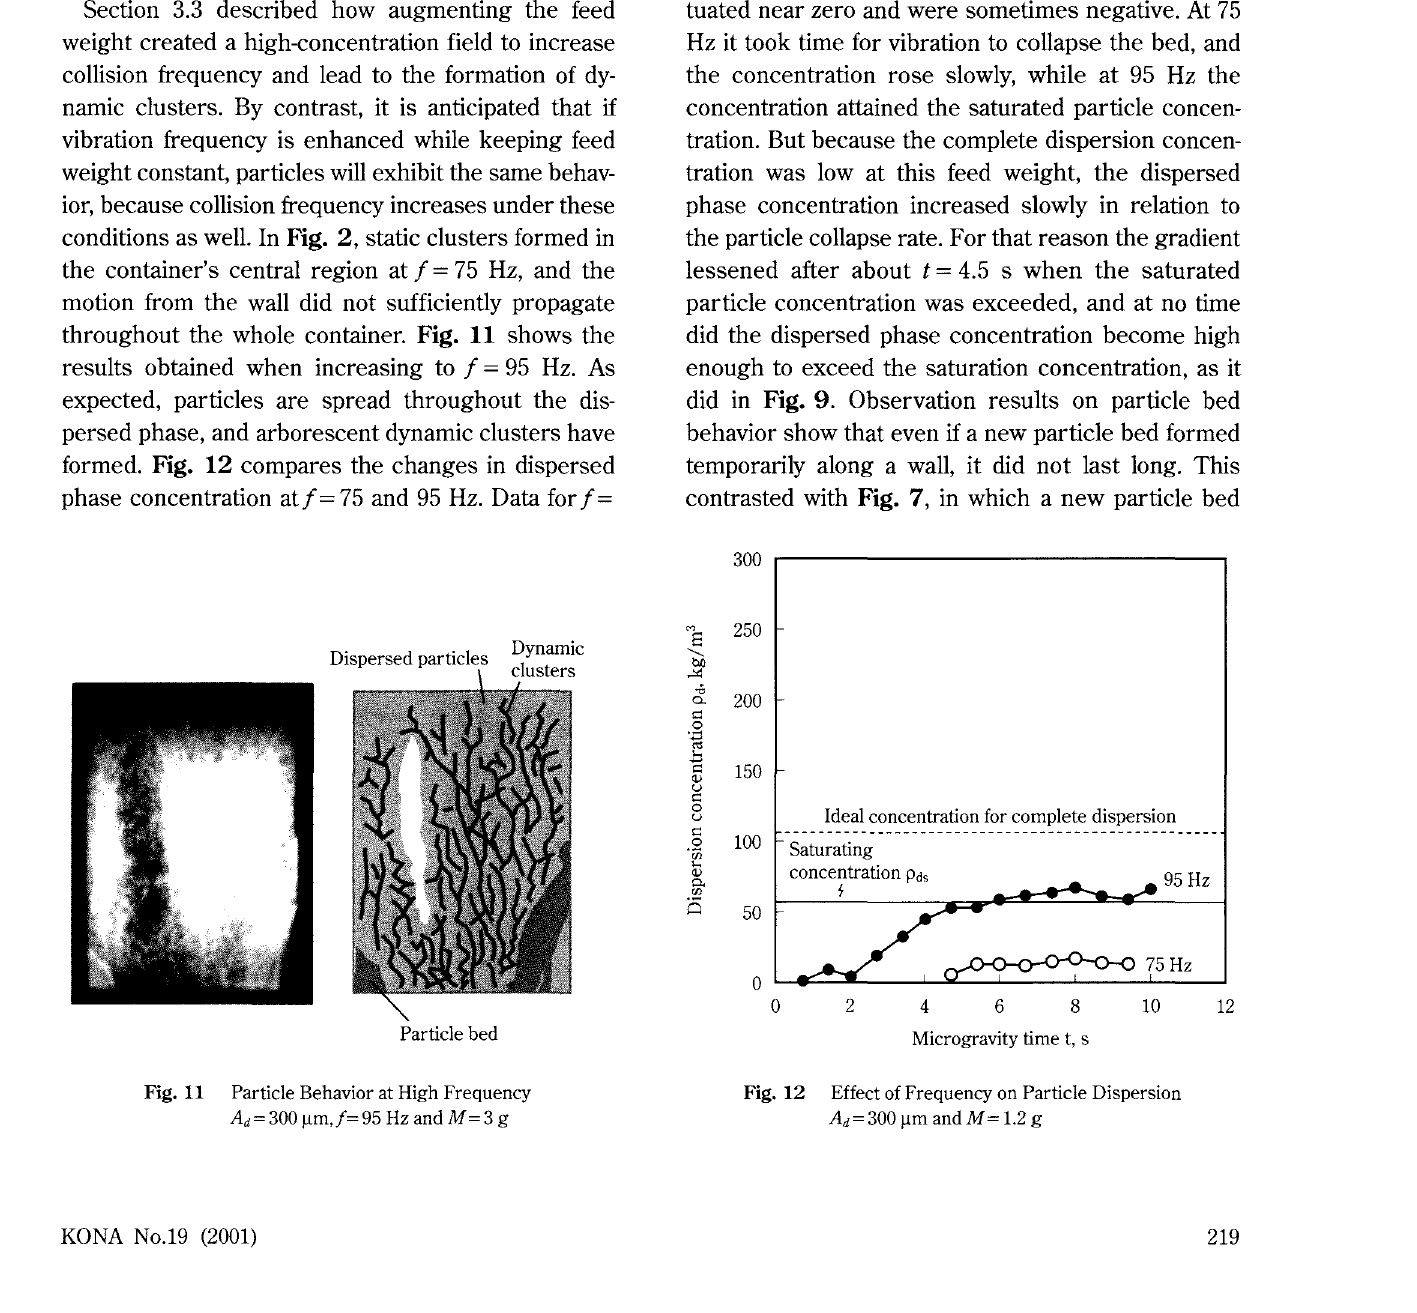
KONA No.19 (2001)